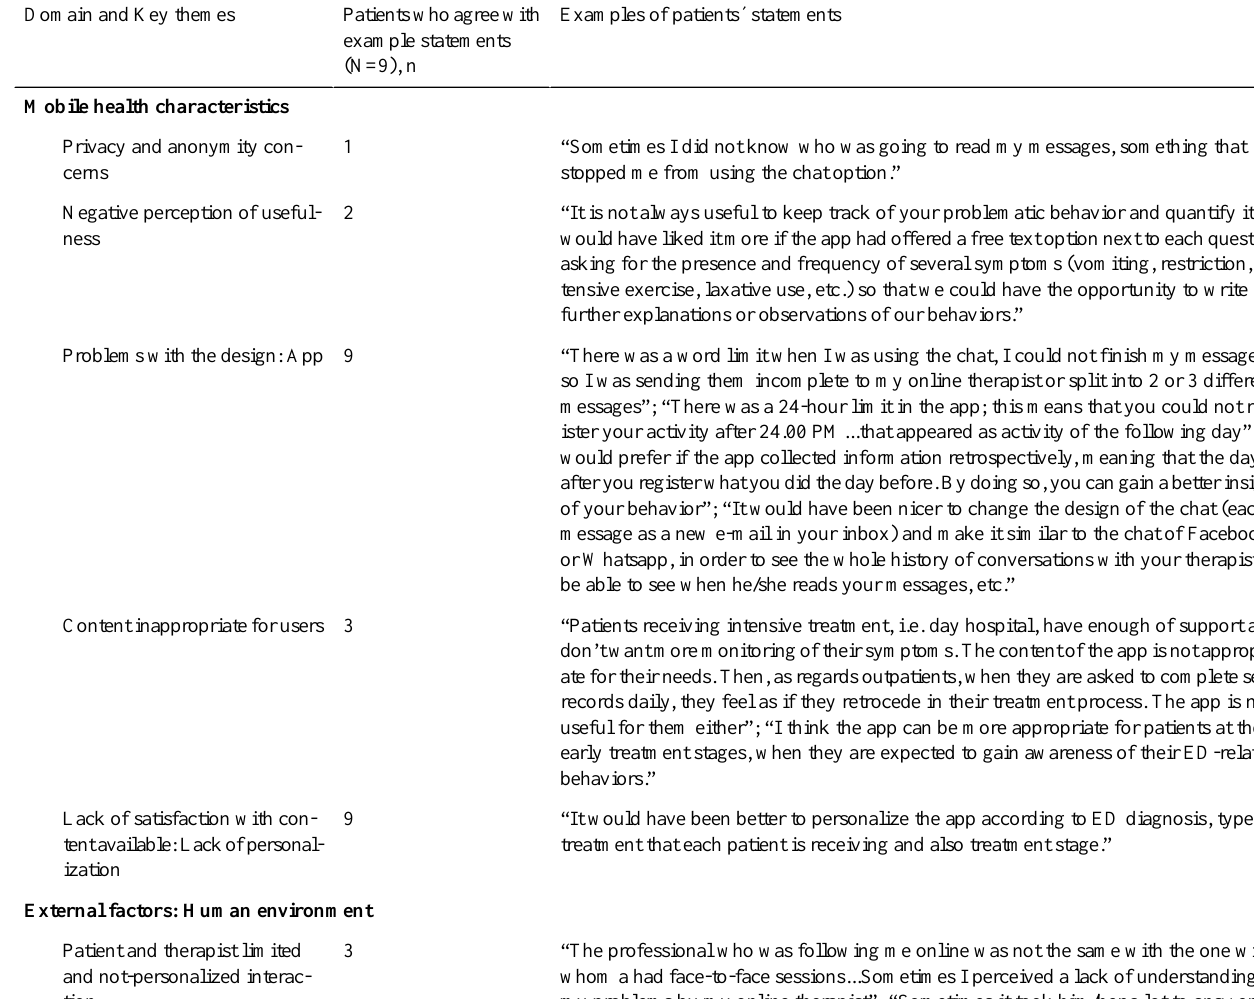
Table 6. Perceived disadvantages of the TCApp by patients.